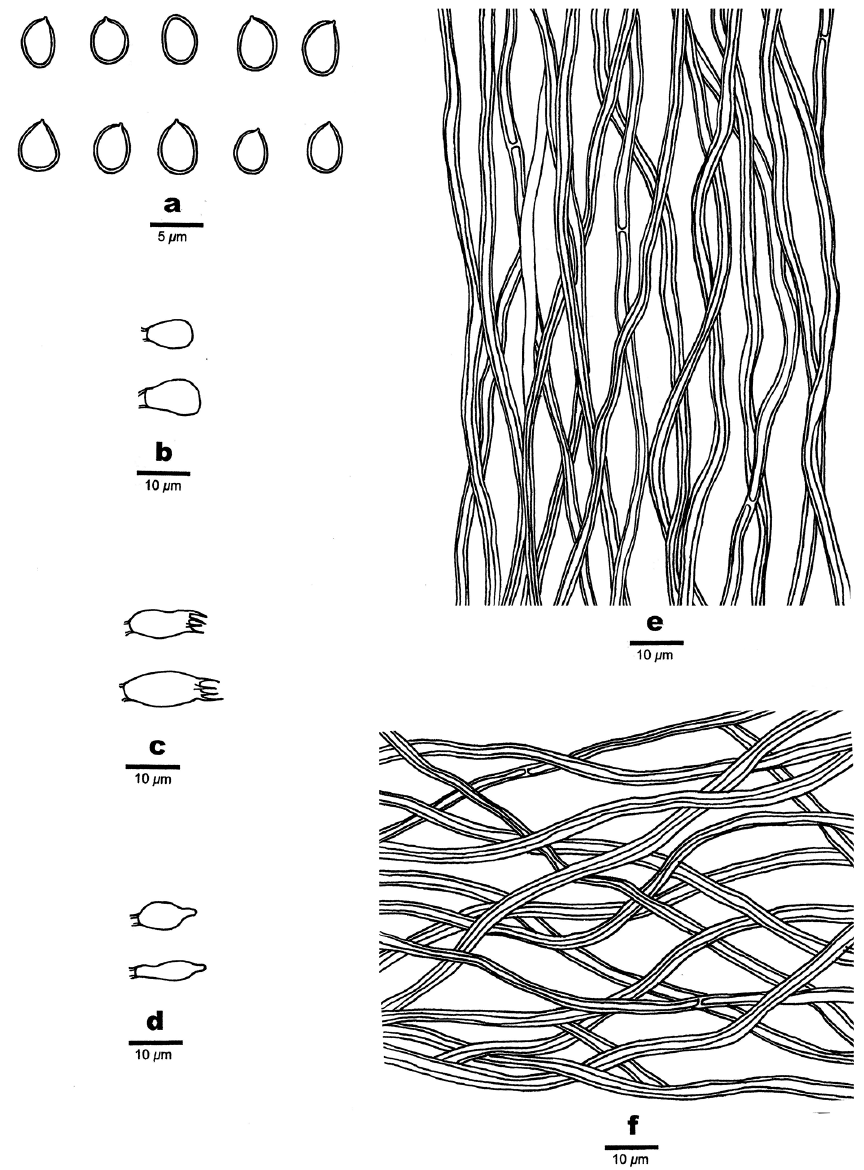
Figure 8. Microscopic structures of Fomitiporella vietnamensis . a Basidiospores b Basidioles c Basidia d Cystidioles e Hyphae from trama f Hyphae from